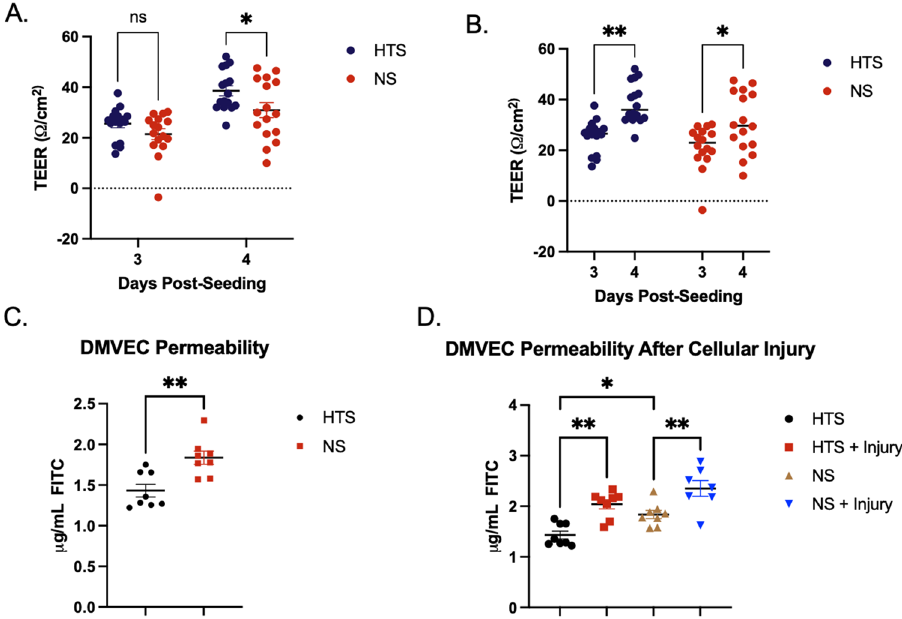
Figure 3. DMVECs from burn HTS have decreased barrier function and increased permeability compared to NS DMVECs. TEER was measured after 3 and 4 days in culture from burn HTS and NS DMVECs. Comparing burn HTS versus NS ( A ) and burn HTS and NS over time ( B ). FITC-dextran assays were used to assess permeability between burn HTS and NS ( C ) and in cells after injury ( D ). p < 0.05*, p <